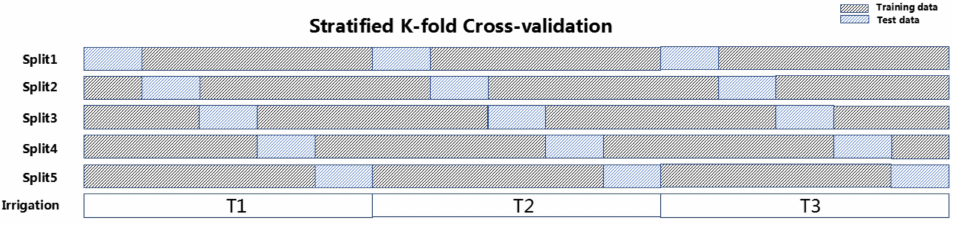
Figure 6. Stratified 5-fold cross-validation at different